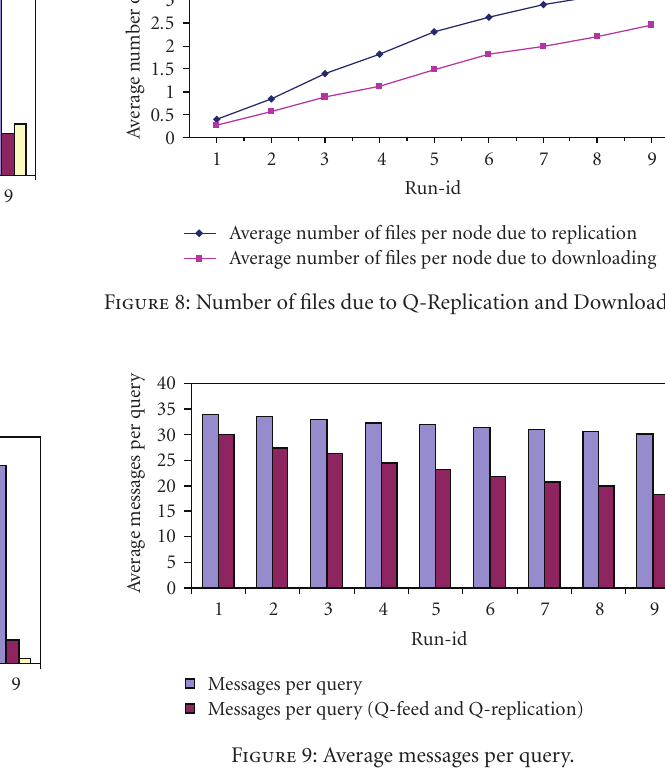
Figure 9: Average messages per